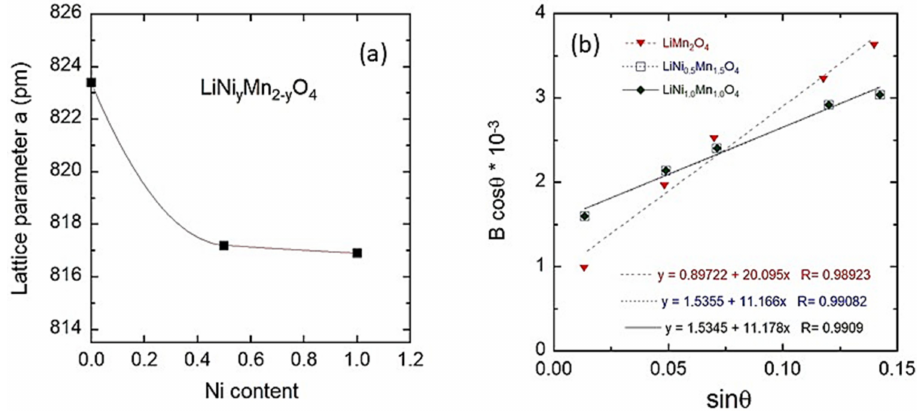
Figure 2. ( a ) Evolution of the refined lattice parameters a and crystal volume V as a function of Ni content in LiNi y Mn 2 − y O 4 (0 ≤ x ≤ 1). ( b ) Analysis of the full-width B at half-maximum of XRD peaks according to Equation (1). B is expressed in radian ( b ).